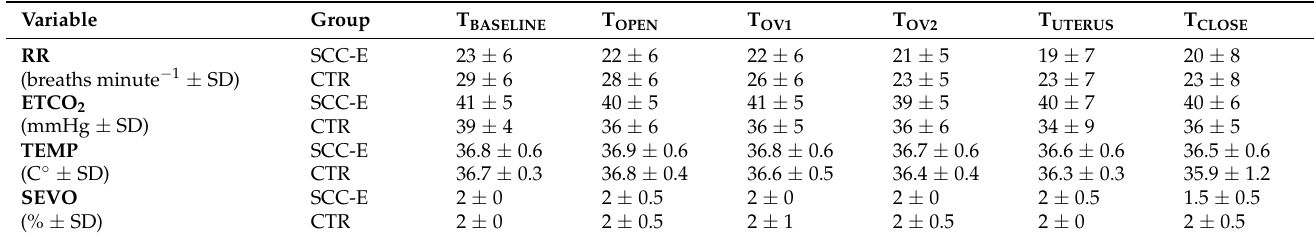
Table 3. Mean and standard deviation (SD) of intra-surgical respiratory rate (RR), end-tidal carbon dioxide (ETCO2), expired fraction sevoflurane (SEVO), and temperature (TEMP) values in cats undergoing ovariohysterectomy with (SCC-E group) or without (CTR group) sacrococcygeal epidural ( n = 10 in each group).